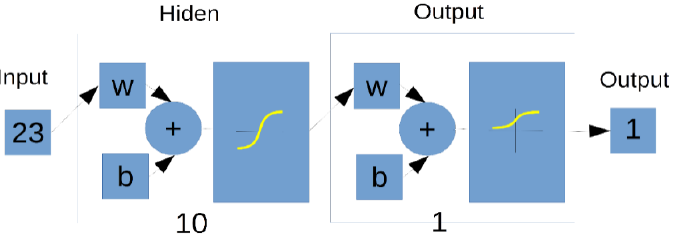
Figure 10. The structure of the neural network as it was implemented for the needs of the analysis. The number of inputs was 23, the number of neurons in the hidden layer, 10. The network contains one unipolar response type output.